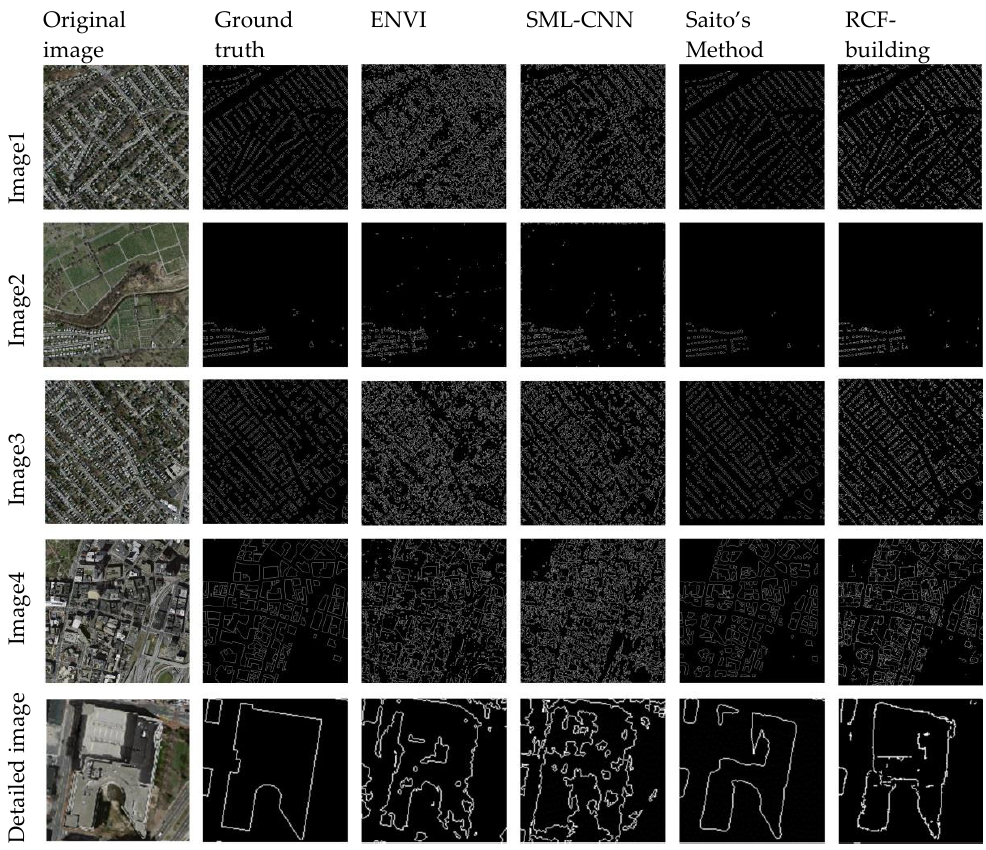
Figure 10. Building edges detection results on Massachusetts Building Dataset. The last row shows the details image of one building. Table 2. Evaluation results of four different methods on four typical images.